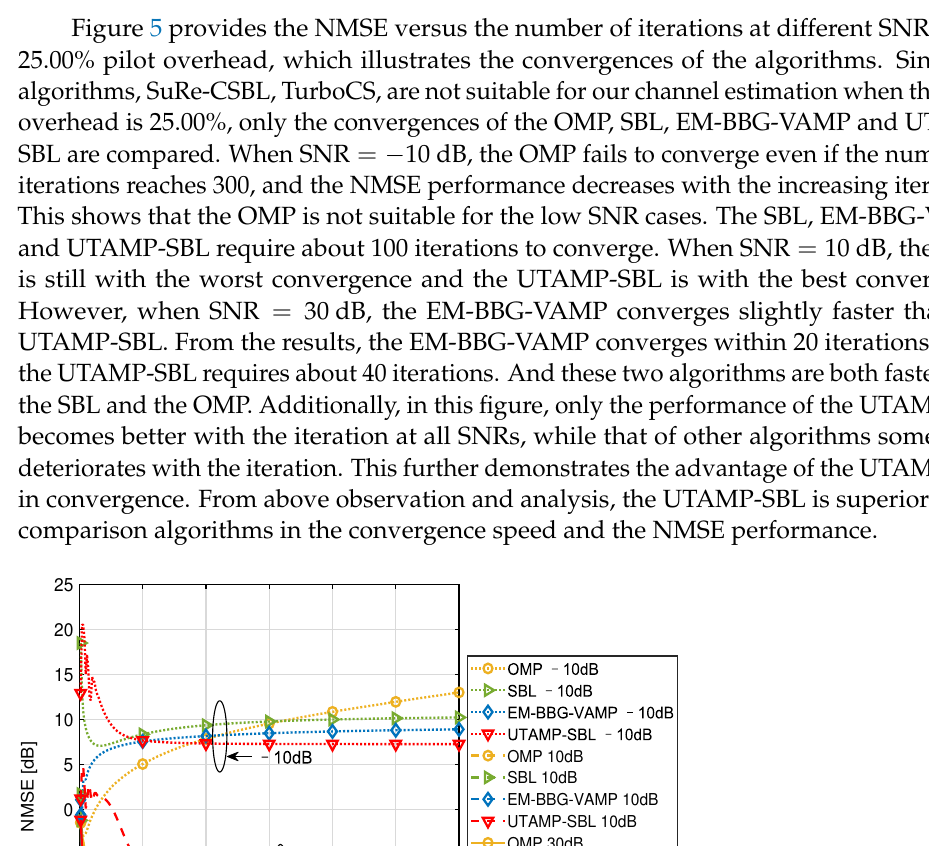
Figure 4. The NMSE versus the SNR with 25.00% pilot overhead.